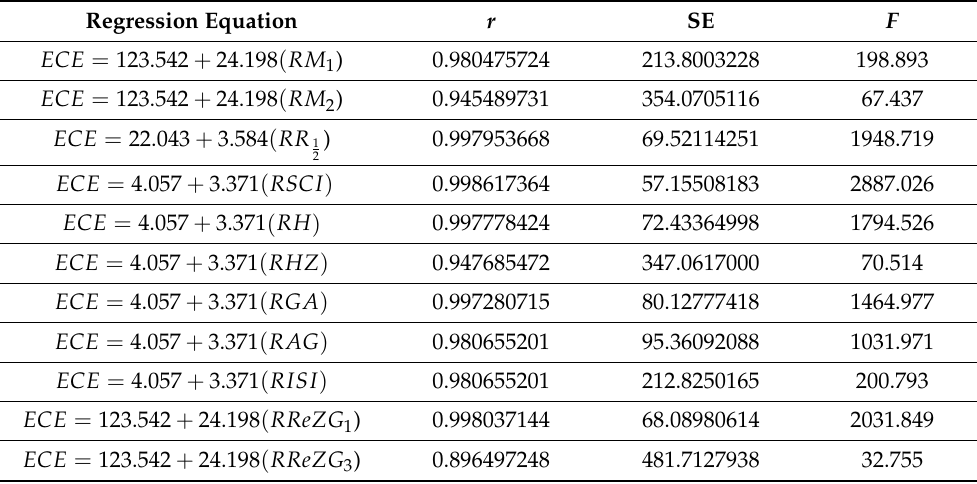
Table 4. Linear prediction models with statistical parameters of the exchange-correlation energy of graphene sheets from C 6 to C 32